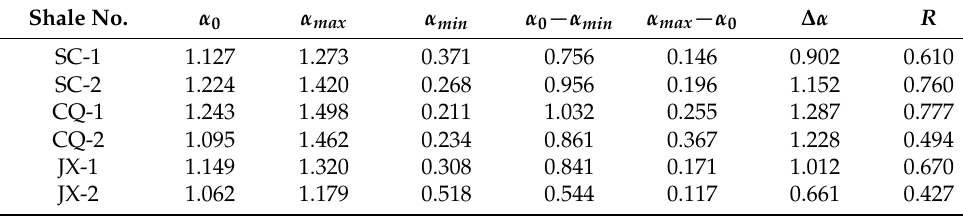
Table 5. Characteristic parameters from multifractal spectra of inorganic shale pores. Shale